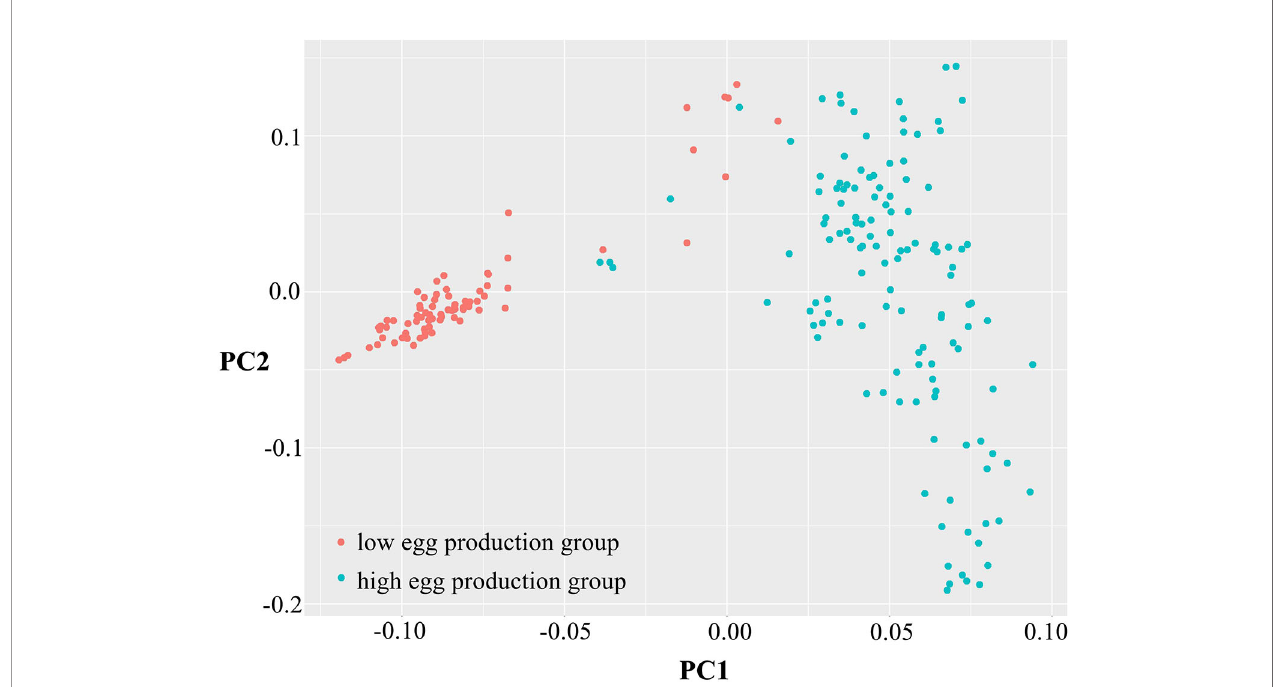
FIGURE 2 | Principal component analysis of egg production. Principal component 1 (PC1) and principal component 2 (PC2) values comprised the X-axis and the Y- axis and were used to draw the scatter gram, and each dot represents one sample. Red points represent low-yield samples and blue points represent high-yield samples.